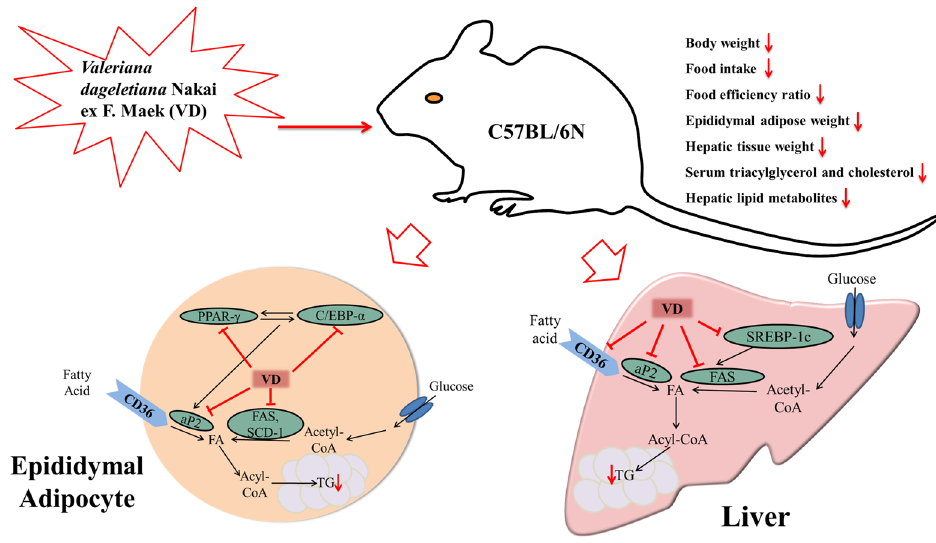
Figure 6. Proposed mechanisms of the anti ‐ obesity effect of VDAE.